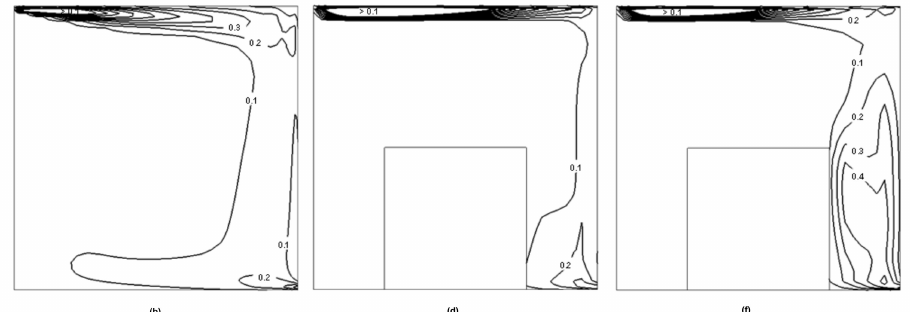
Figure 3. Contours of normalized velocity (top) with superimposed sketches of flow stream pattern and turbulence kinetic energy (bottom) on a streamwise midplane ( x, y, z = L /2) for three cases (i.e.,